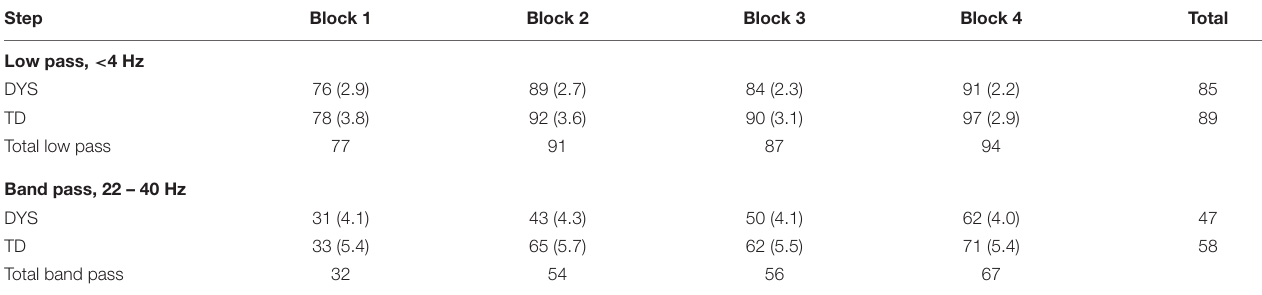
TABLE 2 | Recognition accuracy (% target rhymes identified) by presentation block, with standard errors in